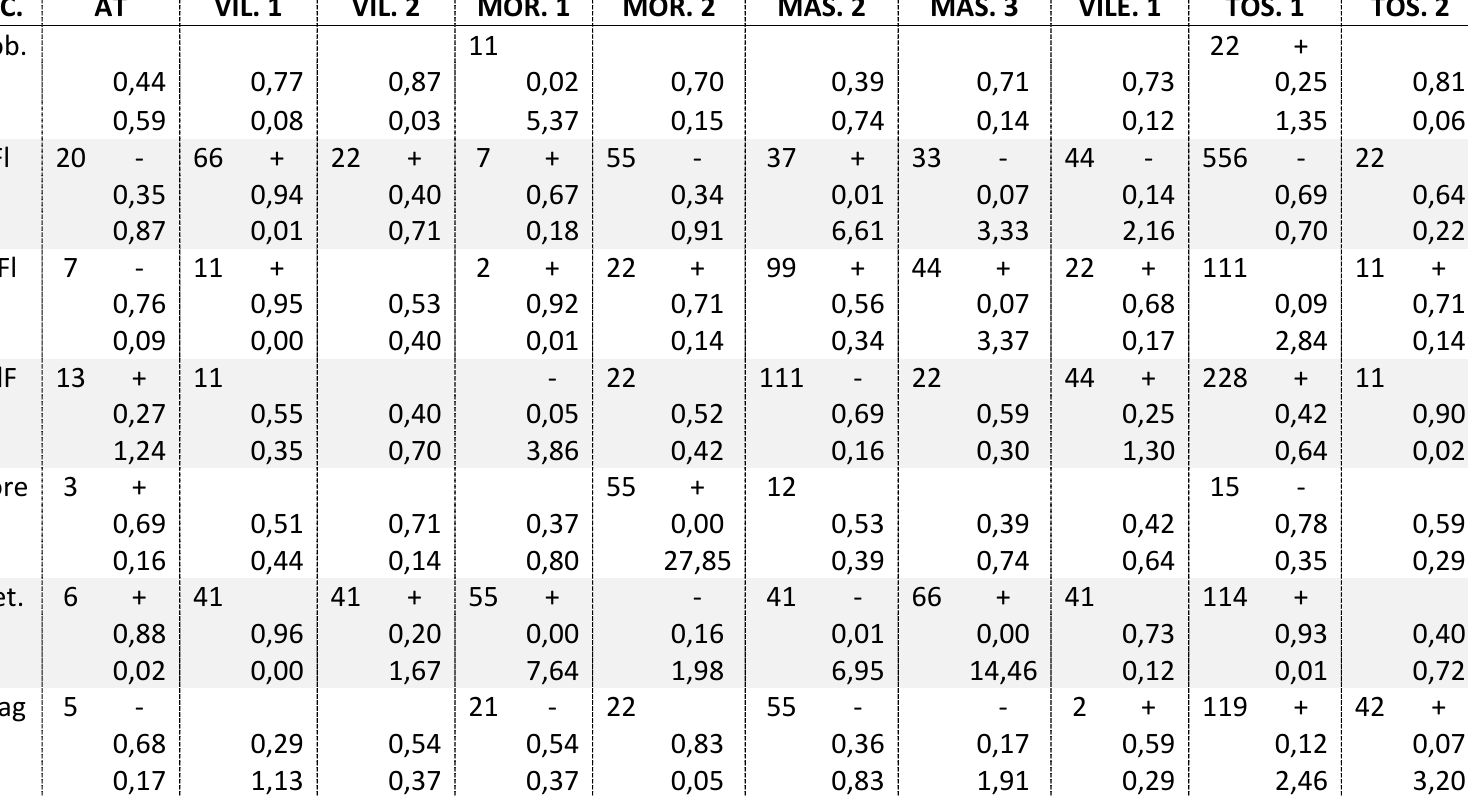
Table 4. Chi-square results presented in two columns: 1. Lithic remains described; 2. a) Heterogeneity sign according to the expected value: (+) overrepresented or (-) underrepresented in the assemblage. b) Statistical probability. c) Chi-square value. Abbreviations: AT.Altered types; Vil..Vilaplana; Mor. Morera; Mas. Maset; Vile. Vilella; Tos. Tossa (Rows). Cob. Cobbles; Fl. Flake; FFl. Fragmented Flake; FlF. Flake Fragment; Ret. Retouched tool: Frag. Fragments